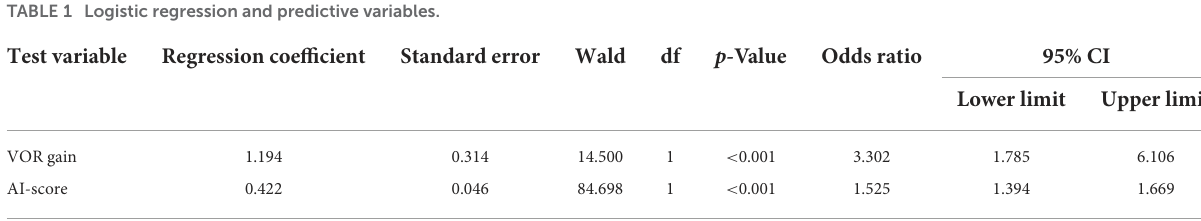
TABLE 1 Logistic regression and predictive variables.